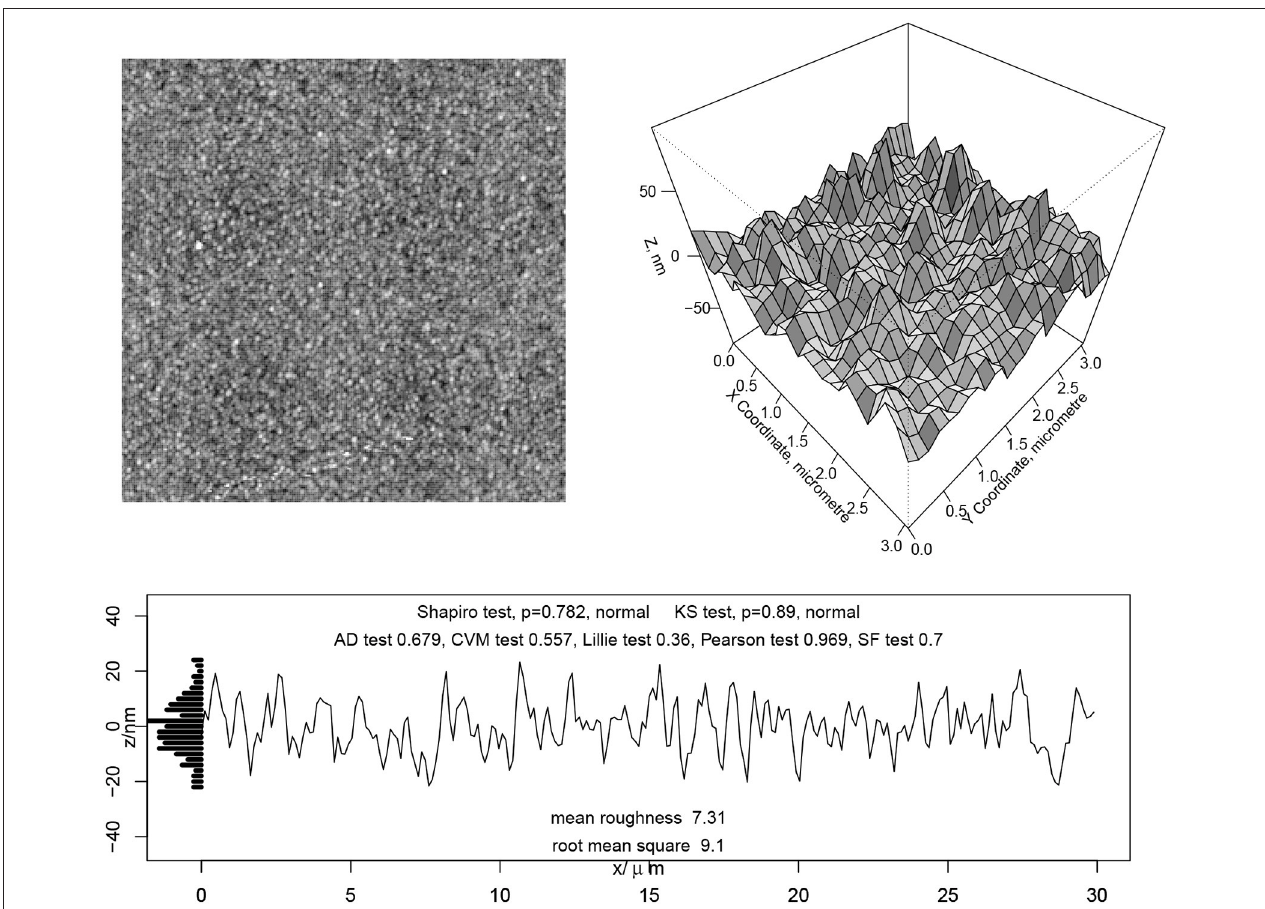
FIGURE 2 | The AFM scan of the a-C sample. (Left) full measured patch 30 x 30 µ m . (Right) extracted small region 3 x 3 µ m . (Bottom) A typical profile with normality tests and two descriptive statistics (values are in nm): the root mean square (rms) and the mean